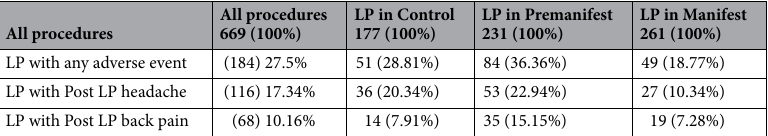
Table 2. Observed frequencies of adverse events at all included LP visits.